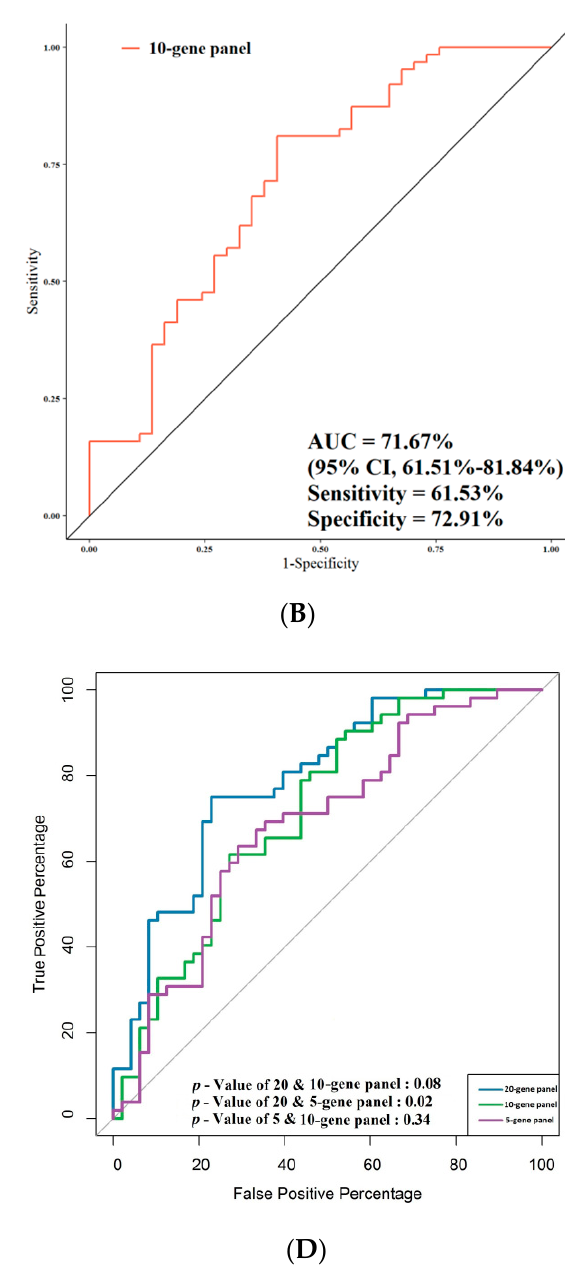
Figure 6. Comparison of the predictive performance by receiver operating characteristic (ROC) curve analysis for stage. ( A ) The AUC assessment of the logit( p ) value for the panel of 5 genes. ( B ) The AUC assessment of the logit( p ) value for the panel of 10 genes. ( C ) The AUC assessment of the logit( p ) value for the panel of total genes. ( D ) Comparison of the predictive performance for the panel of 5, 10, and 20 genes.